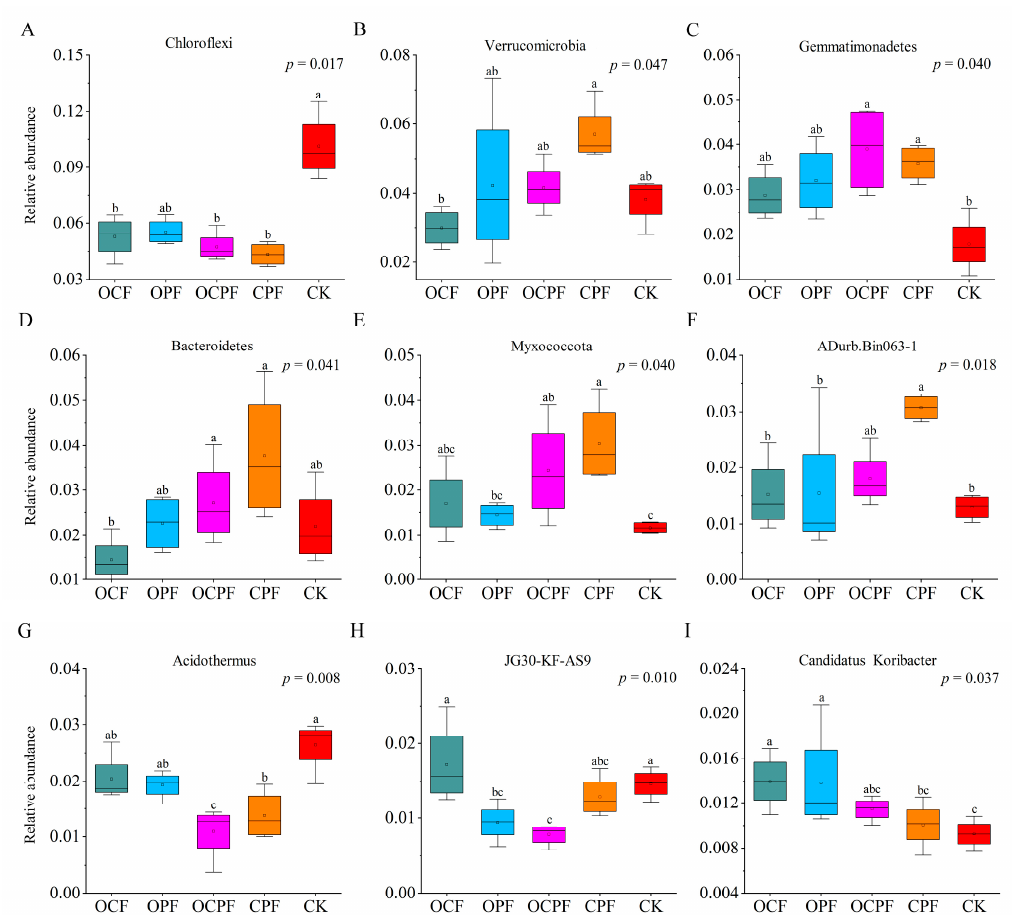
Figure 3. Changes in bacterial community composition among different treatments at the dominant phylum ( A – E ) and genus ( F – I ) level. Significant differences are shown by different lowercase letters at a significance level of 0.05 according to the Kruskal − Wallis test.